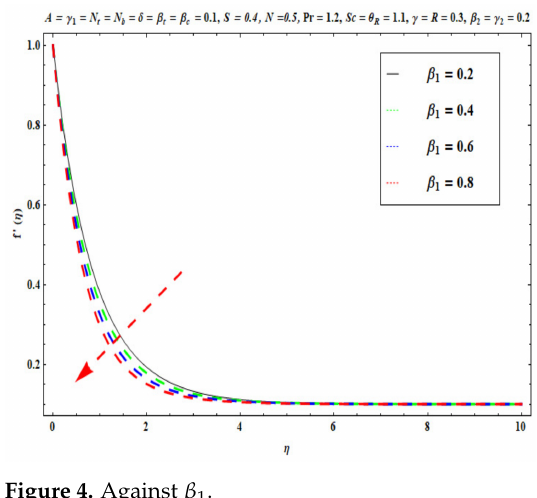
Figure 4. Against β 1 .